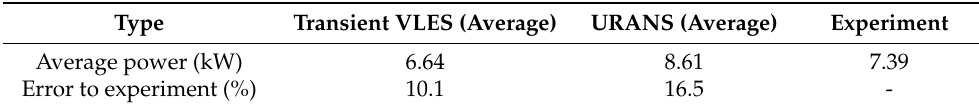
Table 6. Comparison of CFD power values with experimental data (wind speed 10 = m/s).